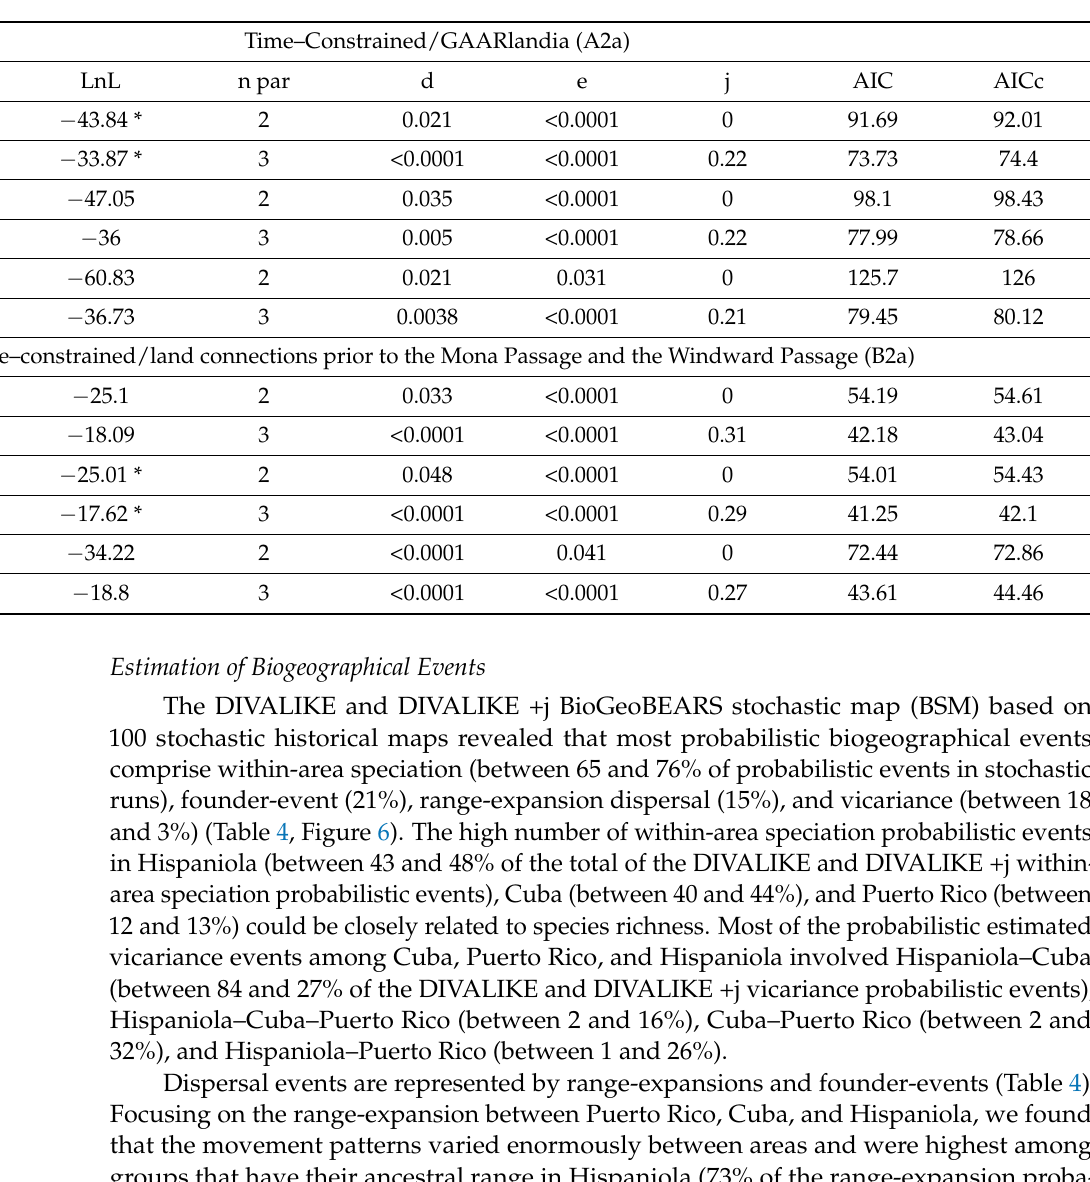
Table 3. BioGeoBEARS’ relative model probabilities for non-time-stratified analyses and time– stratified analyses corresponding to the most likelihood specific scenario A2a of the 12 specific scenarios tested for the non-GAARlandia and GAARlnadia hypotheses, and B2a of the 12 specific scenarios tested for the overwater dispersal and land connections prior to the Mona Passage and the Windward Passage hypotheses. The best performing model is marked with an asterisk for groups of analyses. LnL = log likelihood; n par = number of parameters in the analysis; d, e, j = parameters of the model (d = dispersal, e = extinction, j = founder event); AIC = Aikake information criterion; AICc = size–corrected AIC. * = Best-performing model for each groups of